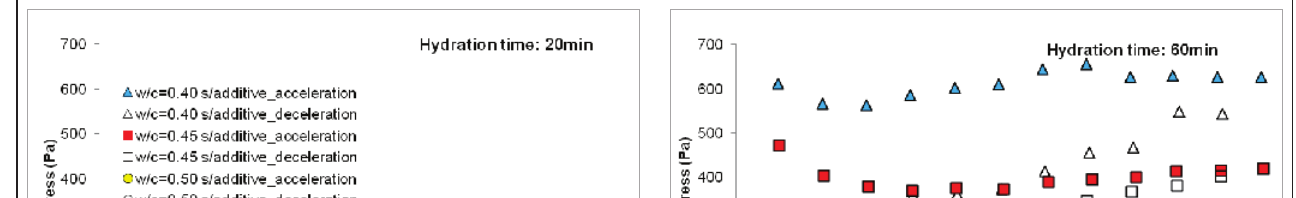
Figure 5 – Shear stress vs. shear rate in cement pastes: (a) without additive and (b) with additive, tested at hydration times 20 and 60 minutes.